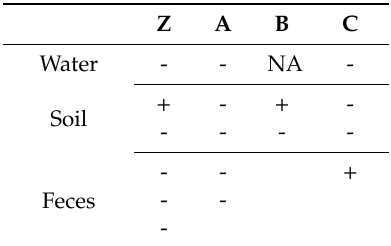
Table 4. Summary of DNA amplification results from environmental samples collected along four transects (A − C, Z) in Devon Avenue. DNA amplified using primer CYCLO18S, “-“ indicates no indicates no sample